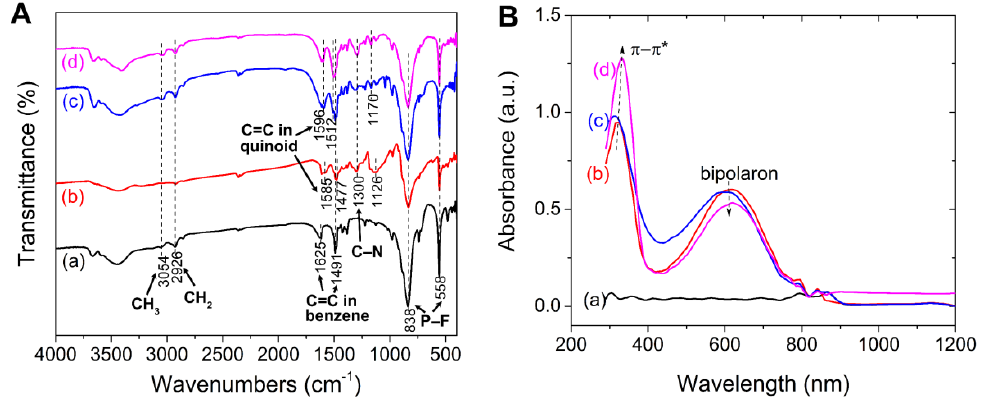
Figure 3. ( A ) FT-IR spectra and ( B ) UV-vis spectra of samples: ( a ) neat PIL, ( b ) PIL/PANI(HCl), ( c ) PIL/PANI(NH 3 ), and ( d ) PIL/PANI(N 2 H 4 ).